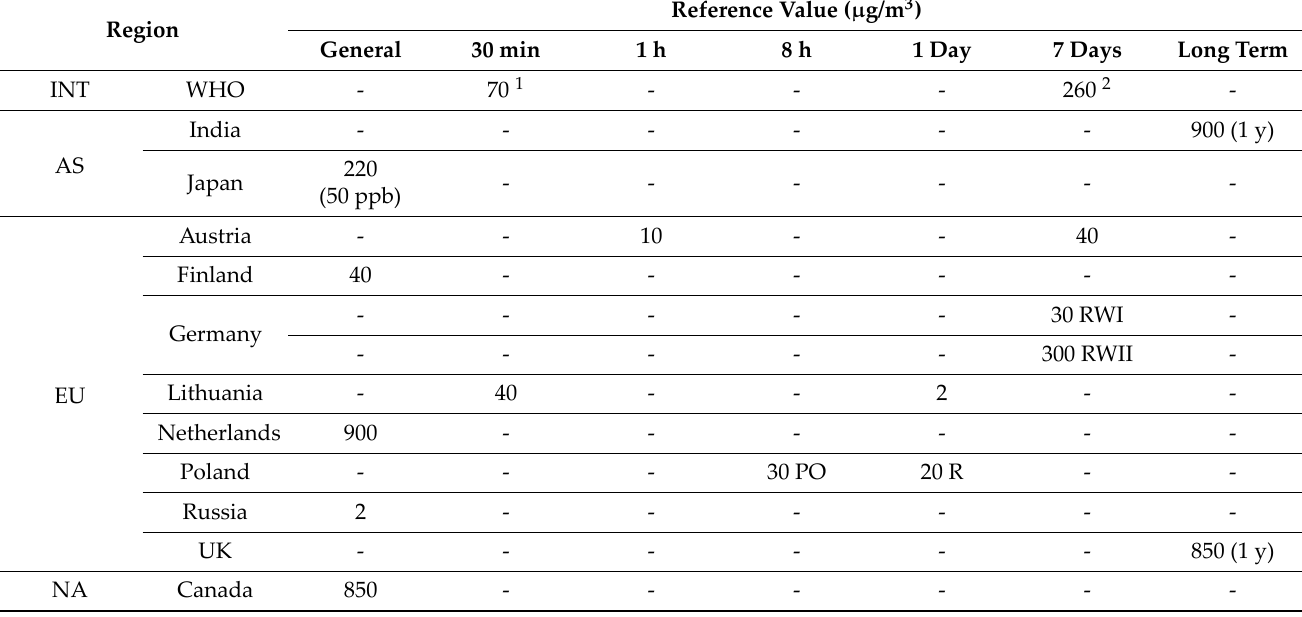
Table 17. Reference values for